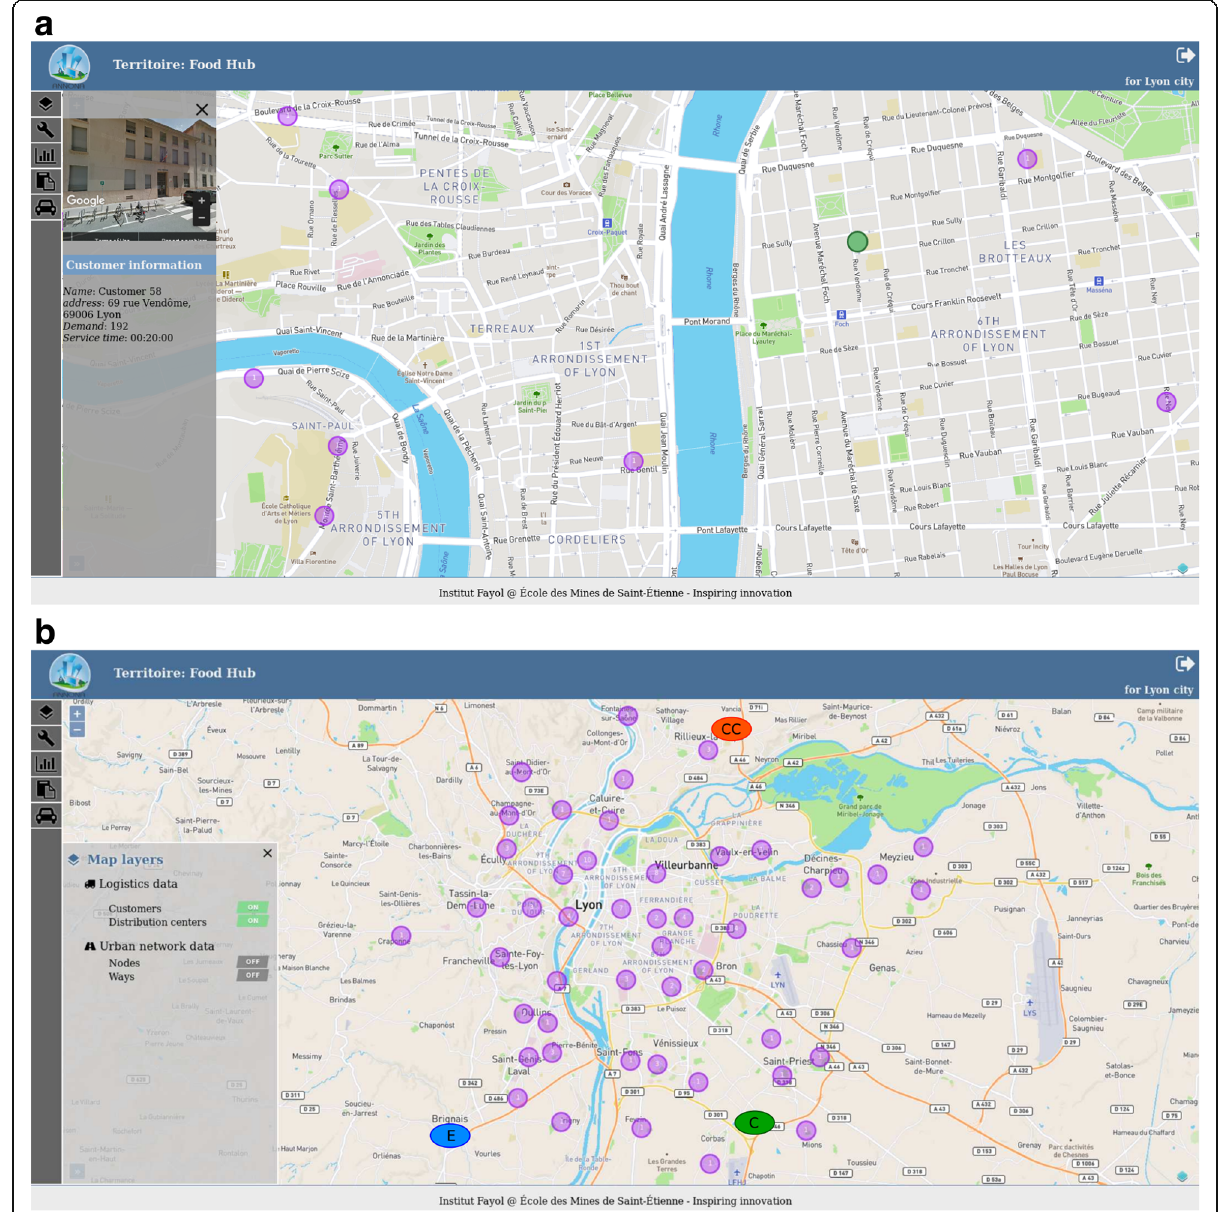
Fig. 2 Great Lyon public middle school canteens (Authors ’ elaboration using the ANNONA platform and OpenStreet Map as base